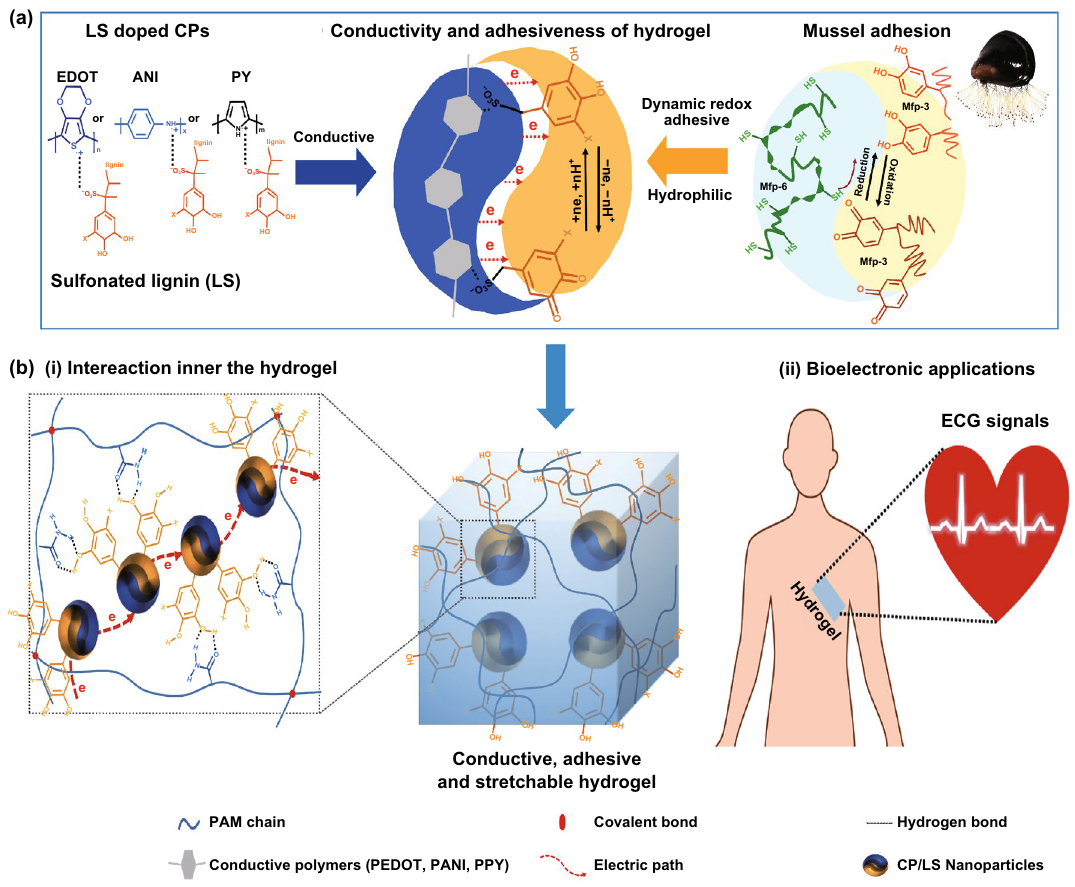
Fig. 1 Preparation of hydrophilic and redox-active conductive polymer/sulfonated lignin (CP/LS) NPs-incorporated conductive and adhesive hydrogels. a Conductive and adhesive mechanisms of the hydrogel. Left: LS-doped CPs, such as PEDOT, PANI, and PPY. Right: mussel adhe- sion mechanism. b CP/LS NPs were incorporated into the hydrogel network to obtain a hydrogel with high conductivity and adhesiveness. (i) The NPs can form physical interaction with the Polyacrylamide (PAM) network and construct conductive pathway inner the hydrogel. (ii) The CH is adhesive and therefore is compatible with human tissue for bioelectronic